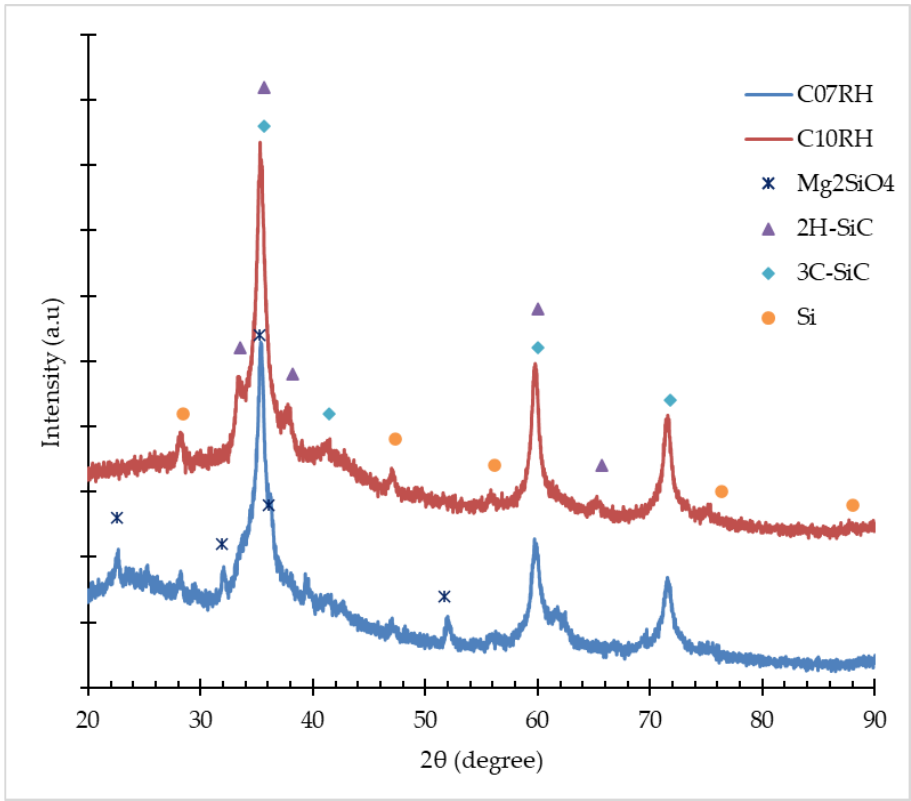
Figure 5. Diffraction pattern of product from washing with 1 M HCl.